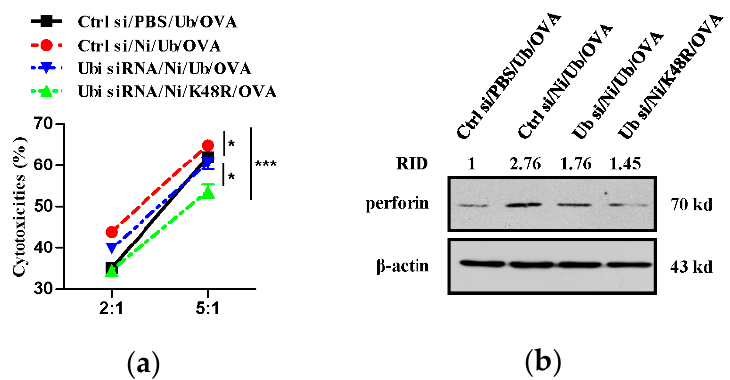
Figure 4. K48 ubiquitination contributes to nicotine-increased cytolytic activities of dendritic cell-activated T cells. ( a , b ) Murine ubiquitin deficient and control BM-DC were stimulated with nicotine (10 − 7 mol/L) for 12~16 h. Then, the cells were replenished with K48R-Ub or WT-Ub (30 × 10 − 6 mol/L) and further incubated with ovalbumin (50 µ g/mL) for 5~6 h. Then, 1 × 10 5 BM-DC was intraperitoneally transferred into C57BL/6 recipients. 5~7 d after adoptive transfer, splenocytes of the recipients were prepared and the cytolytic activities were assessed by incubation of effector cells with CFSE-labeled E.G7-OVA target cells. CFSE value was analyzed by flow cytometry, and the cytolytic activities were calculated ( a ). Perforin expression in the splenocytes of the recipients was determined by Western blot analyses ( b ). For Western blot analyses, β -actin was used as an internal control. Protein level was quantified by ImageJ software and presented as related integrated density (RID). One representative from three independent experiments is shown. Data were pre- sented as the mean ± SEM of replicates from one experiment. * p < 0.05, *** p < 0.001, two-way ANOVA with Newman-Keulspost test. Ni: nicotine; Ub: ubiquitin; si: siRNA; OVA: ovalbumin.